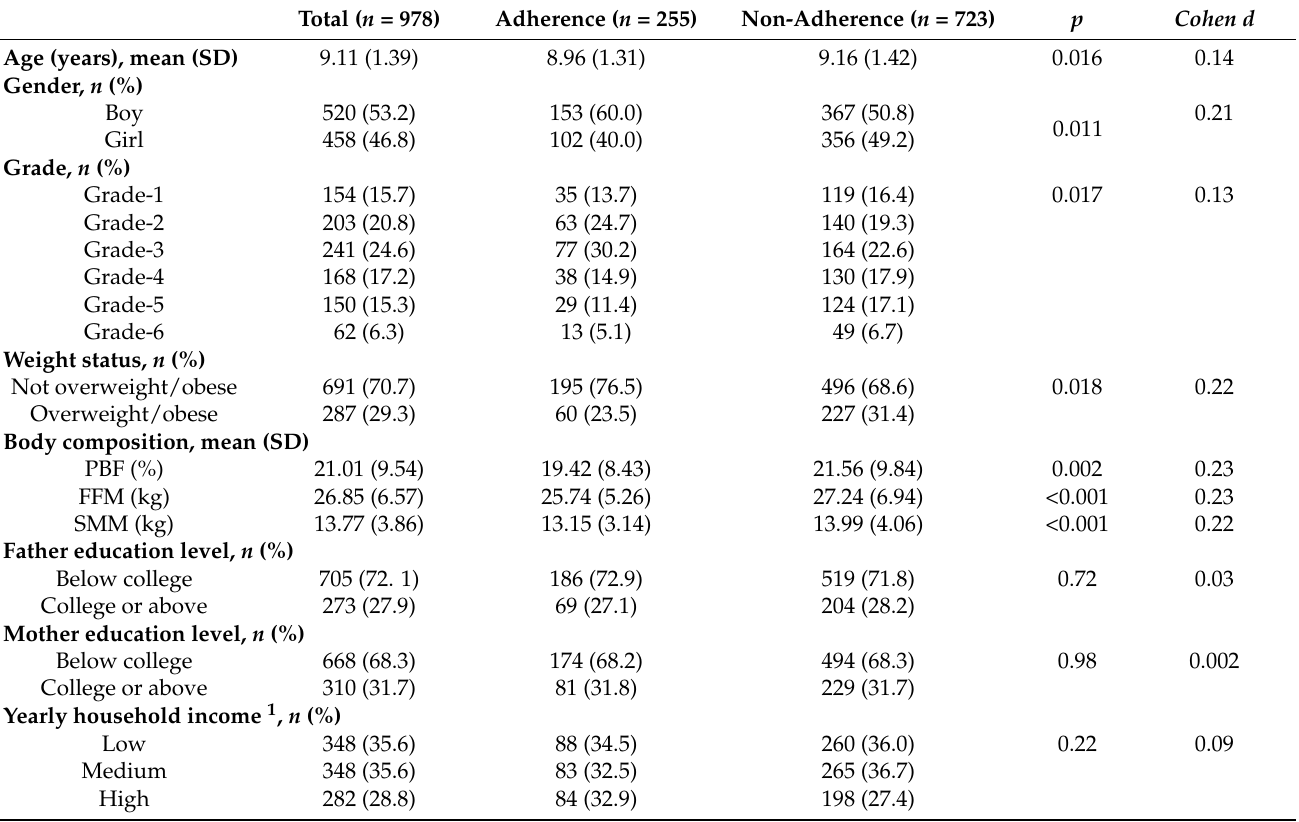
Table 1. Characteristics of the study sample.